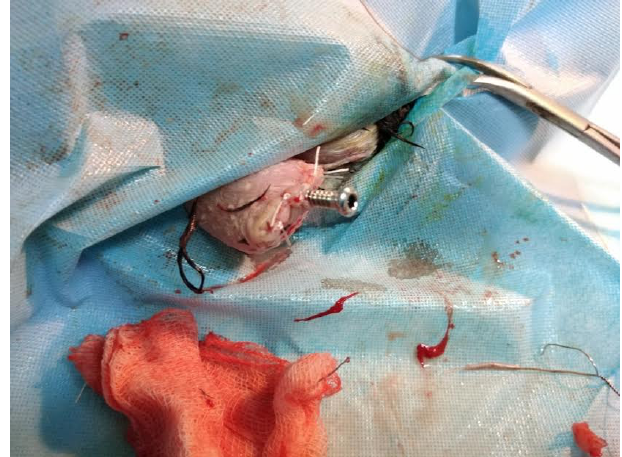
Fig. 3. Screw’s stump as an endoprosthesis tibia leg part Invention for exoprosthesis limb part Two cm outside from screw’s stump was remodeled to exoprosthetic limb part by using acrylic and endotracheal tube (Fig. 4, Fig. 5).